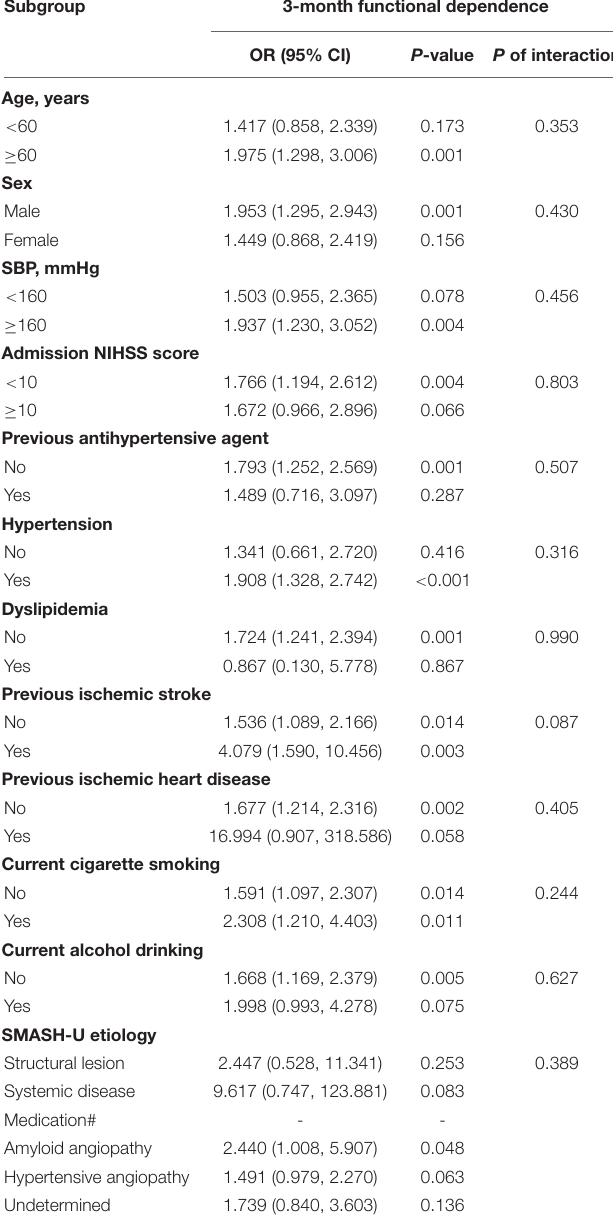
TABLE 3 | Subgroup analysis of the association between recurrent ICH and 3-month functional dependence.